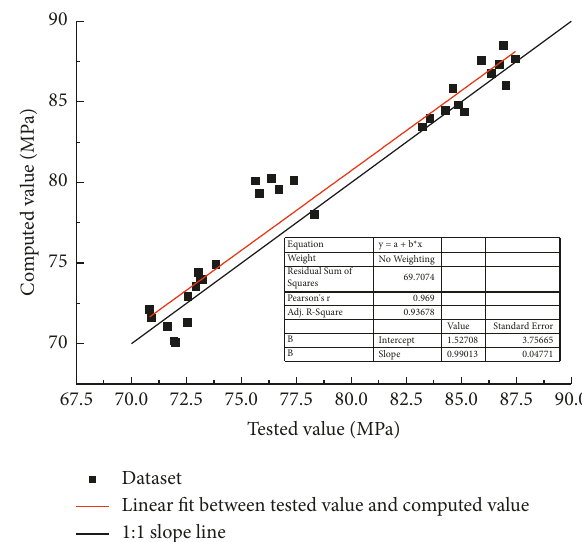
Figure 14: Cross-correlation of tested and computed values from damage variable on v p .